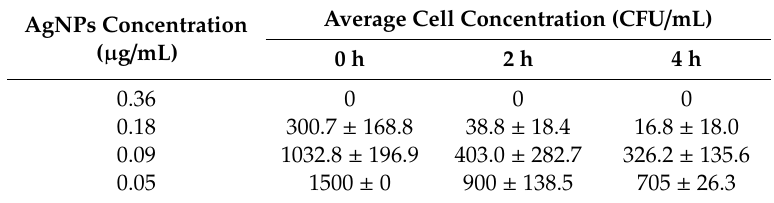
Table 3. Comparison of the inhibitory effects of AgNPs against P. aeruginosa cultures found by different authors.